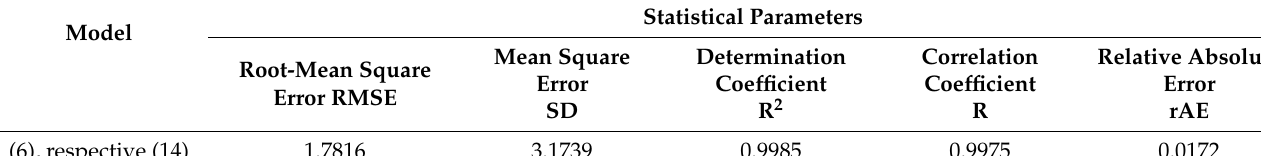
Statistical Parameters